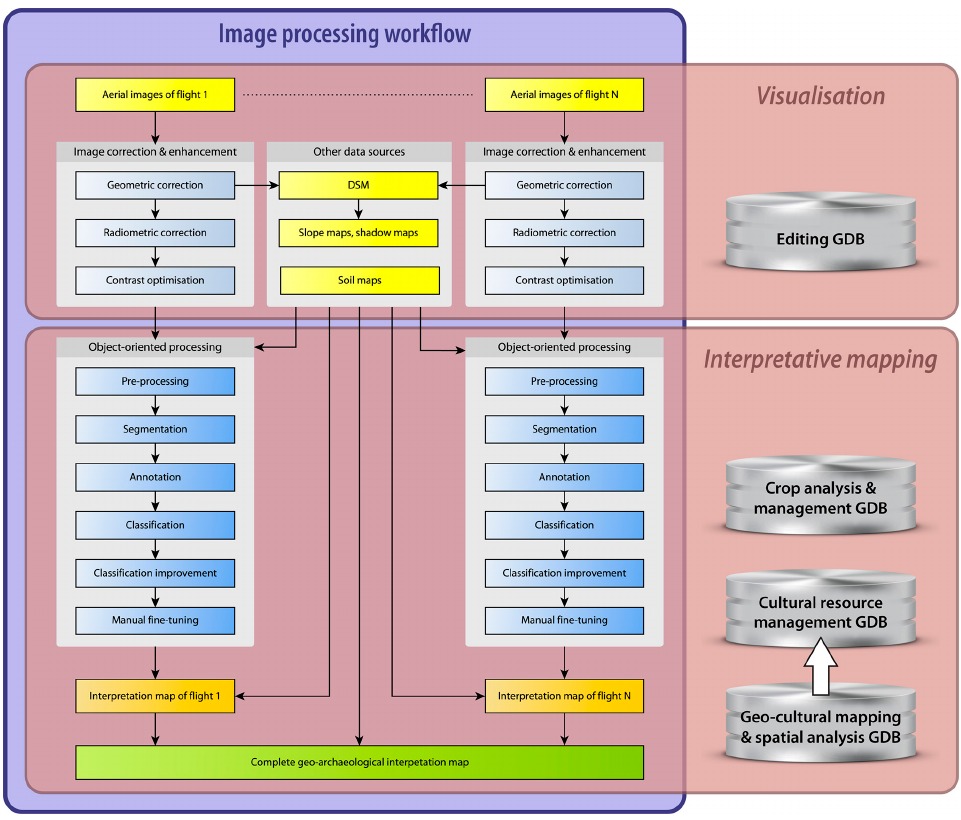
Figure 6. Processing aerial images into geo-archaeological interpretation maps. Alongside, the main functionality of the processing block is indicated together with the storage location of the results.